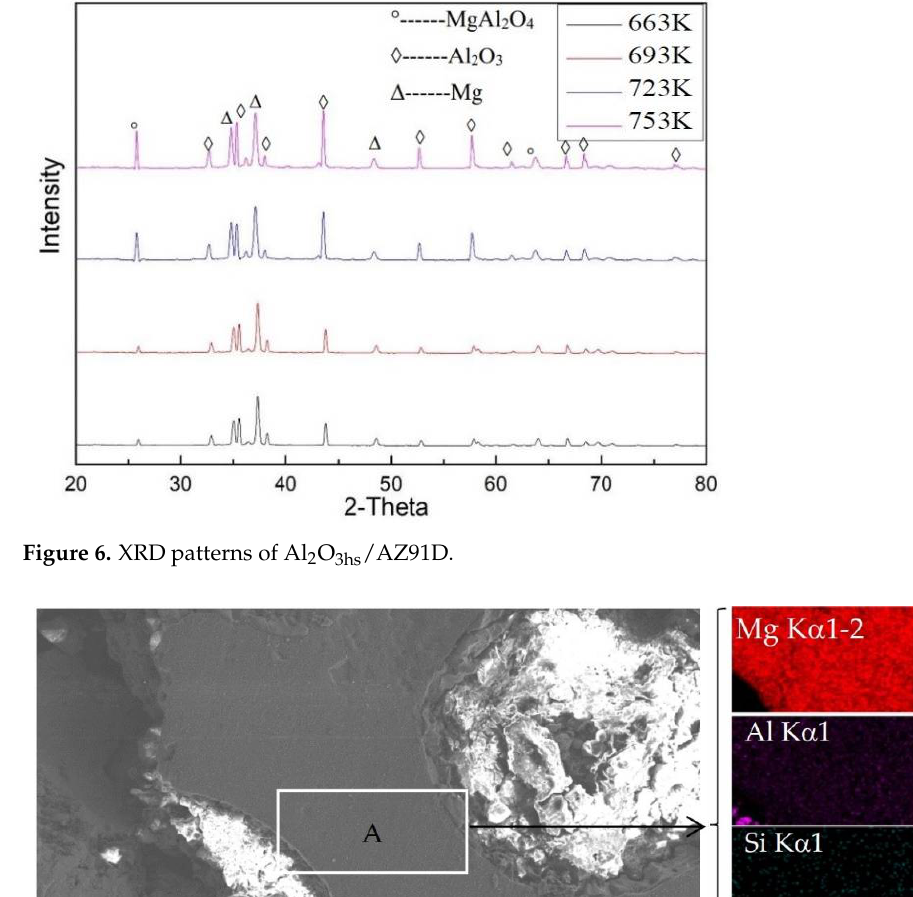
Figure 5. Enlarged image of the area in the box in Figure 4d.